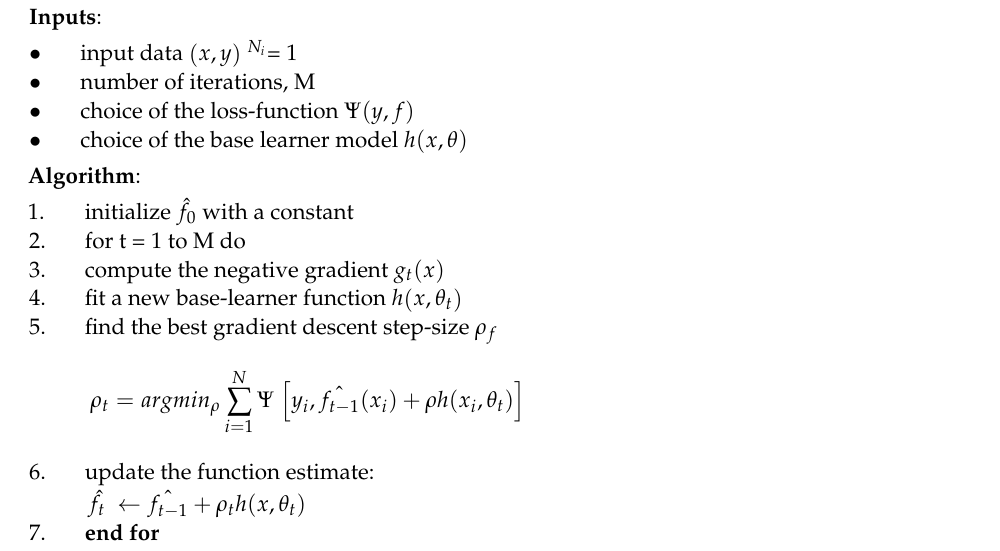
Algorithm 1 : Friedman’s Gradient Boost